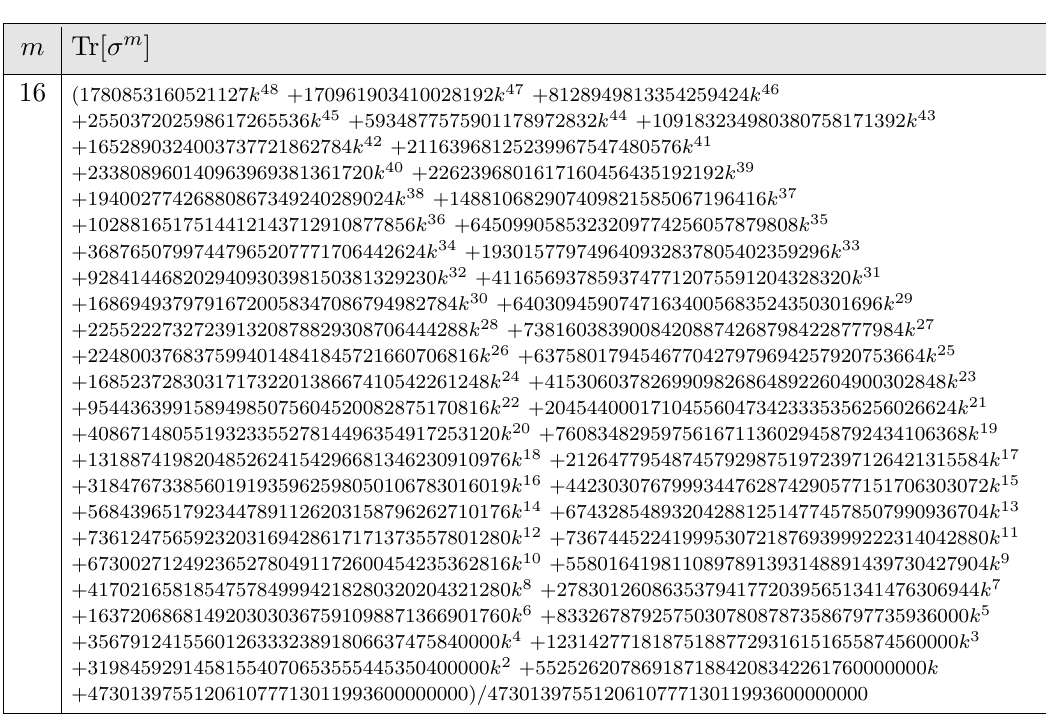
Table 2. The values of Tr [ σ m ] as a function of k for T 3 , 3 torus link. The traces for other